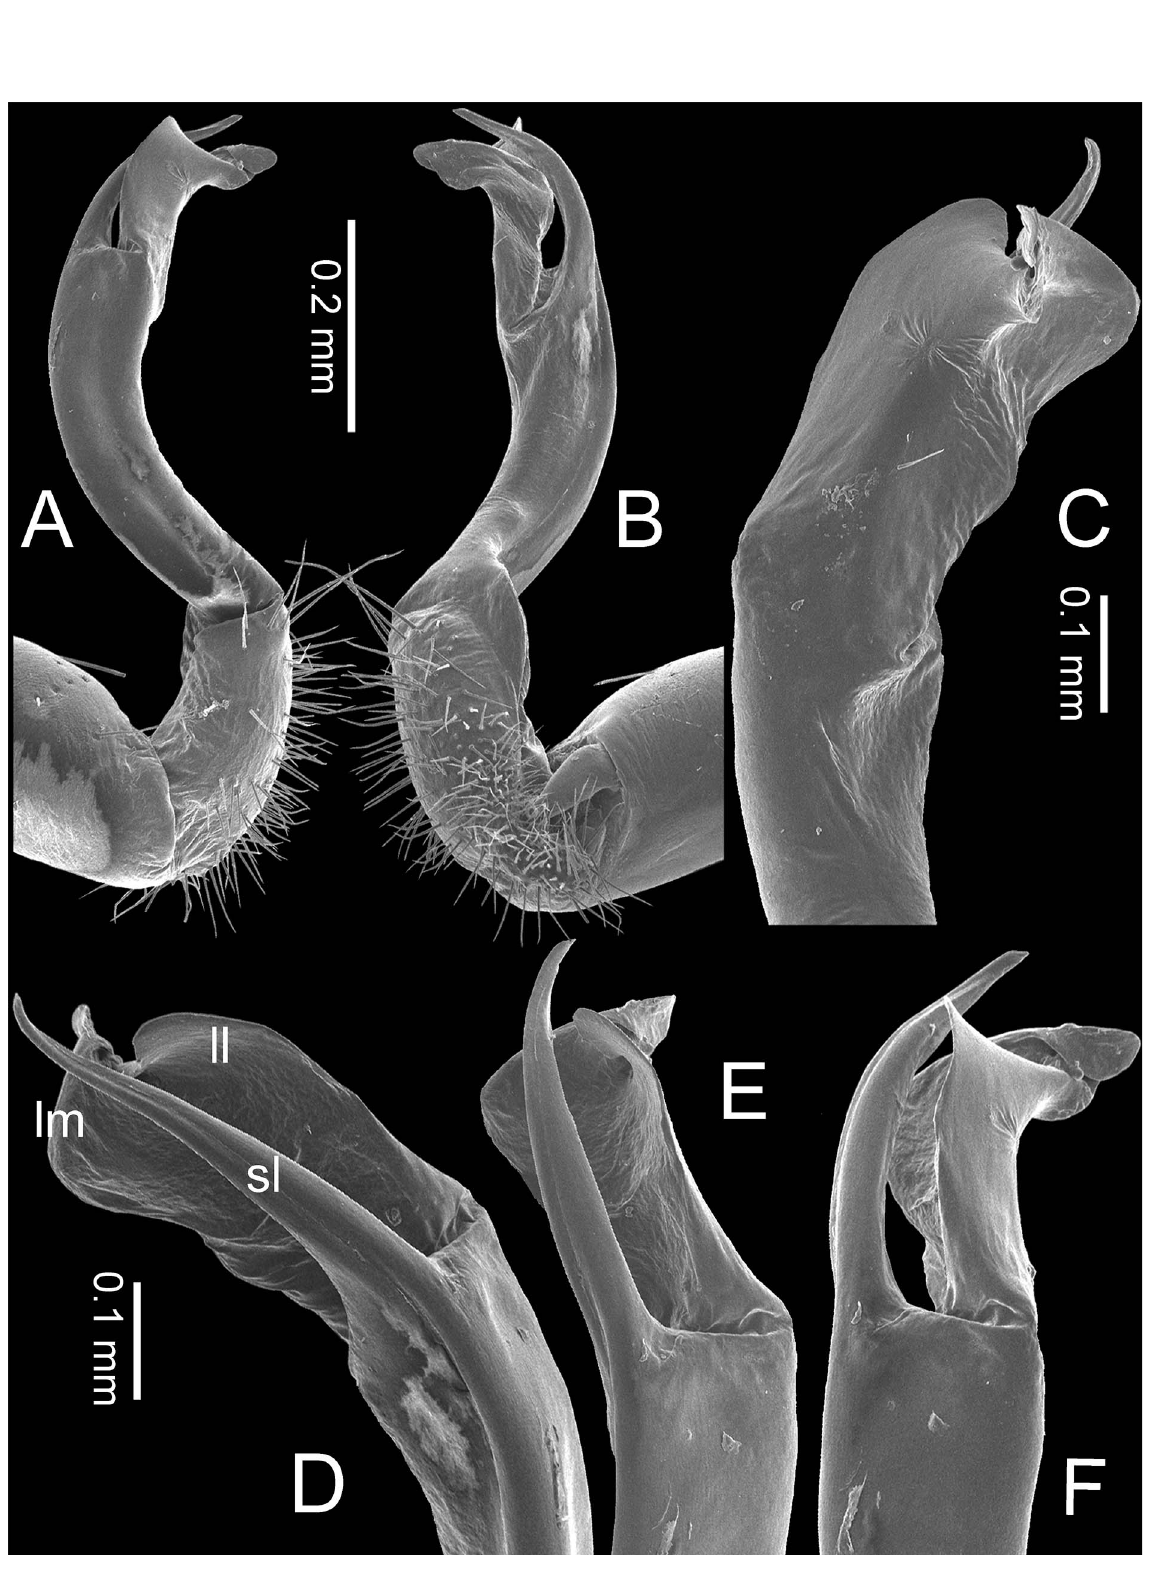
Fig. 18. Gigaxytes parvoterga Srisonchai, Enghoff & Panha gen. et sp. nov . , ♂ paratype – right gonopod. A . Lateral view. B . Mesal view. C . Ventral view. D , F . Subdorsal view. E . Dorsal